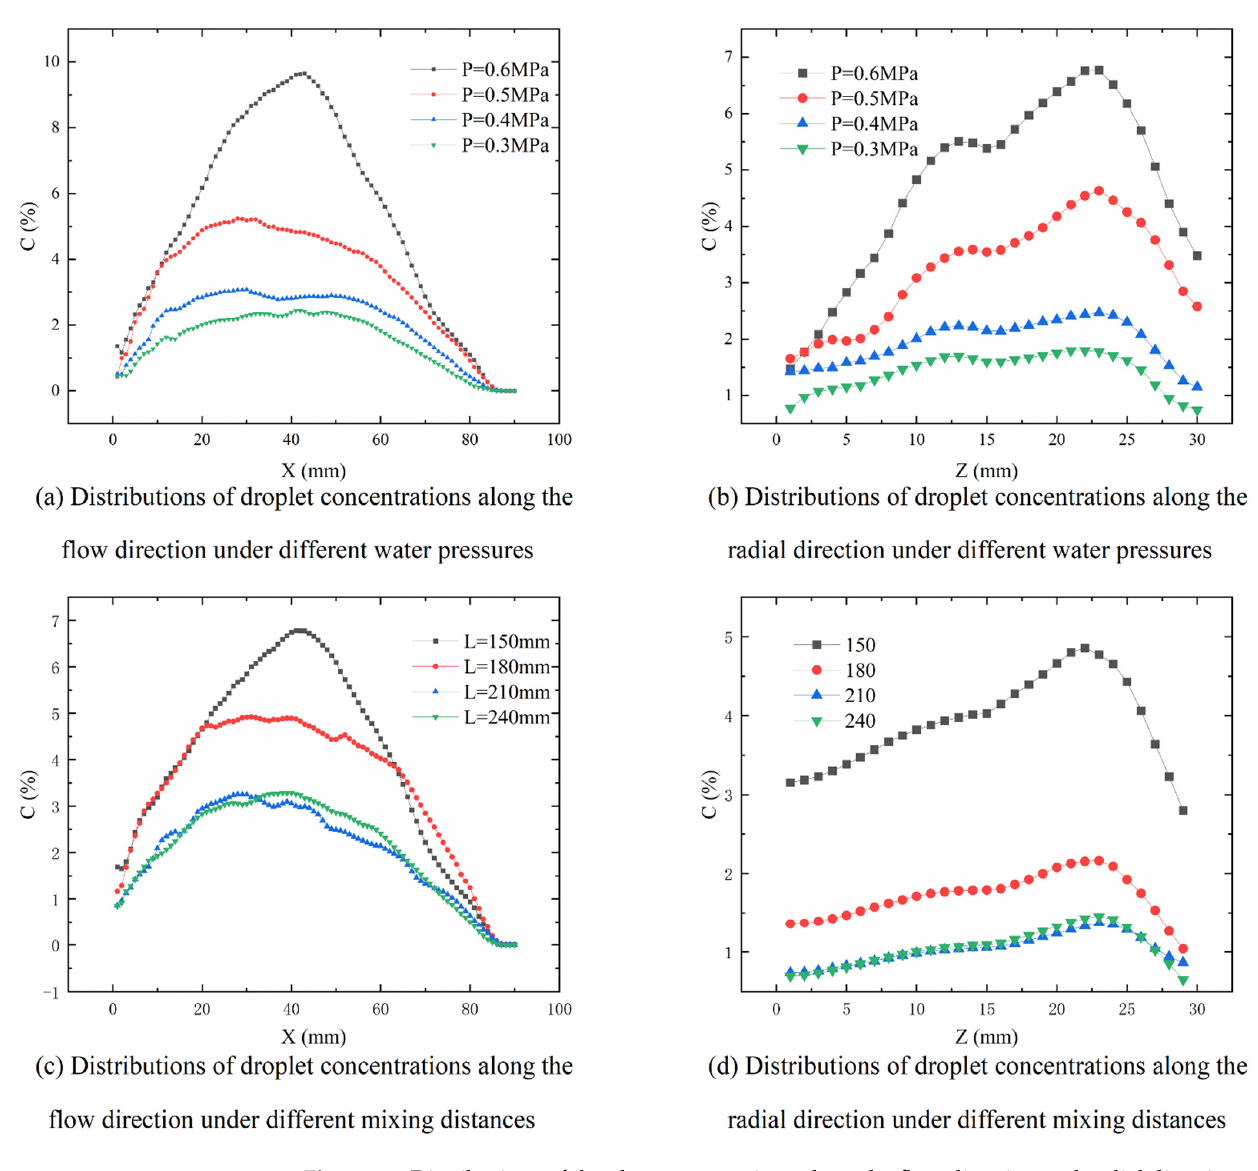
Figure 15. Distributions of droplet concentrations along the flow direction and radial direction. Under a d = 0.4 mm nozzle diameter, P = 0.6 MPa water pressure, ε = 0.3 blockage